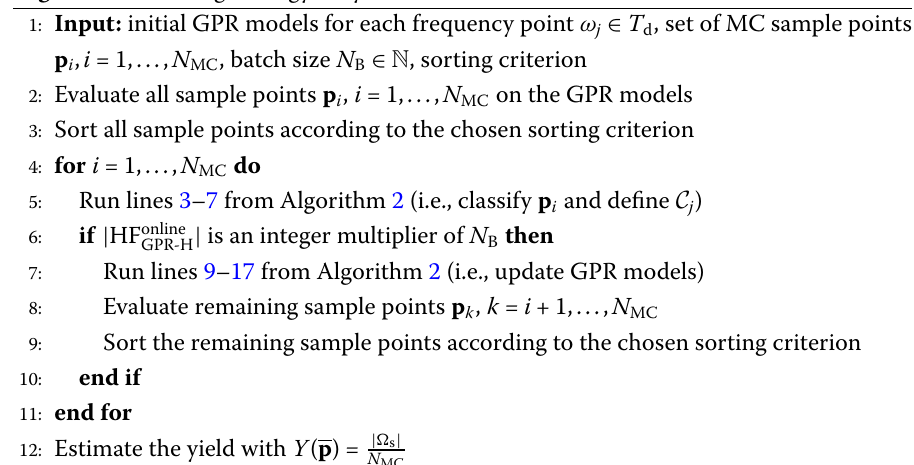
Algorithm 3 Sorting strategy for yield